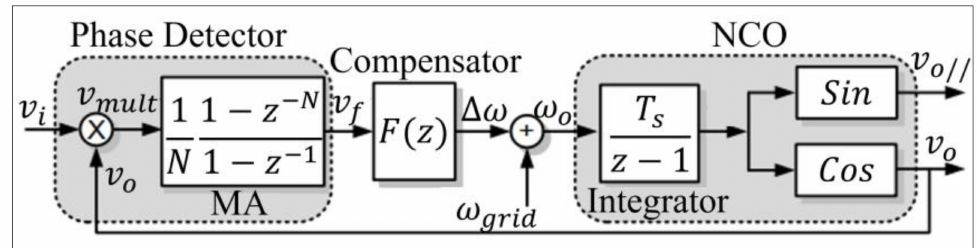
Figure 3. Generalized block diagram of the